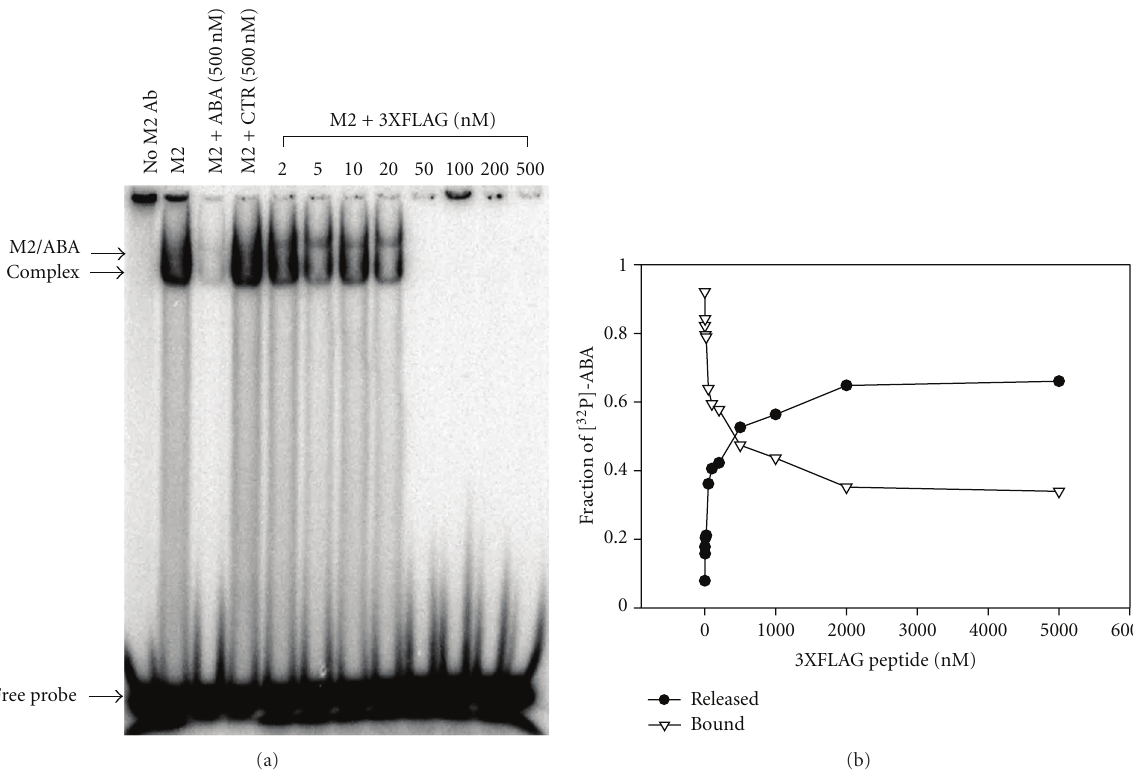
Figure 3: The 3XFLAG peptide blocks the binding of ABA to the M2 antibody. (a) The 3XFLAG peptide prevents formation of the ABA/M2 complex. The M2 antibody was incubated with an increasing concentration of 3XFLAG peptide after which the [ 32 P]-ABA probe was added. Protein/DNA complexes were resolved by electrophoresis in a native polyacrylamide gel. (b) The 3XFLAG peptide elutes the ABA probe already bound to the M2 antibody. The [ 32 P]-ABA was first captured by magnetic beads coated with the M2 antibody. The beads were then incubated with an increasing concentration of 3XFLAG peptide and the amount of [ 32 P]-ABA released and remaining on the beads was counted by scintillation ( n =